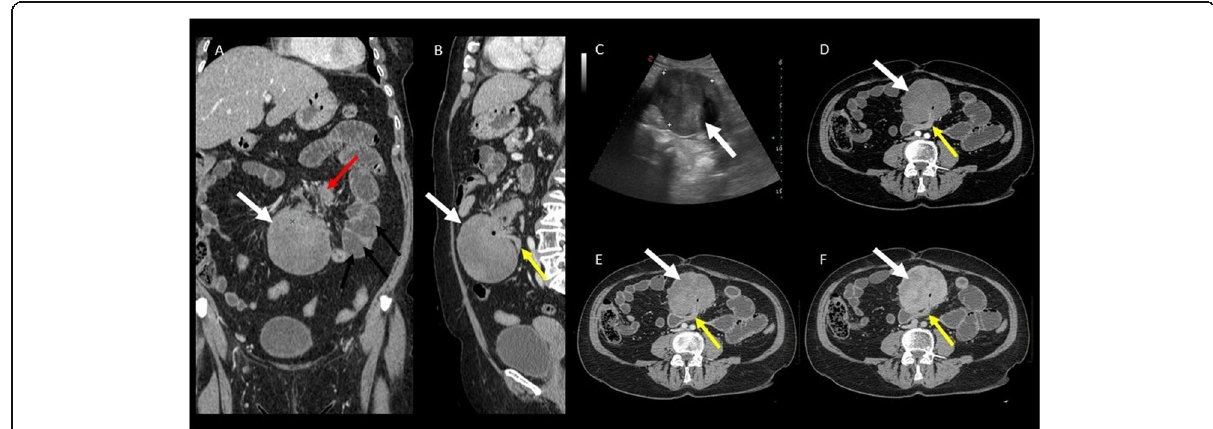
Fig. 9 (Same patient of the previous figure) After 3 years of negative follow-up of the mesenteric mass, the patient was admitted to the emergency room with abdominal pain. CT examination (( a ) coronal and ( b ) sagittal planes) shows a significant growth of mesenteric mass. In particular, it is possible to appreciate two different components: the ill-defined mass previously described (red arrow) and a new large, well- defined mass (white arrow). After contrast administration, the mass is characterized by progressive and homogeneous contrast enhancement (( d ) arterial, ( e ) portal and late venous phase). Moreover, the lesion infiltrates/tethers duodenal loop (yellow arrow) causing overdistension of small bowel (black arrows). US examination ( c ) shows a well-defined homogenous mesenteric mass. Histologic findings confirmed the diagnosis of